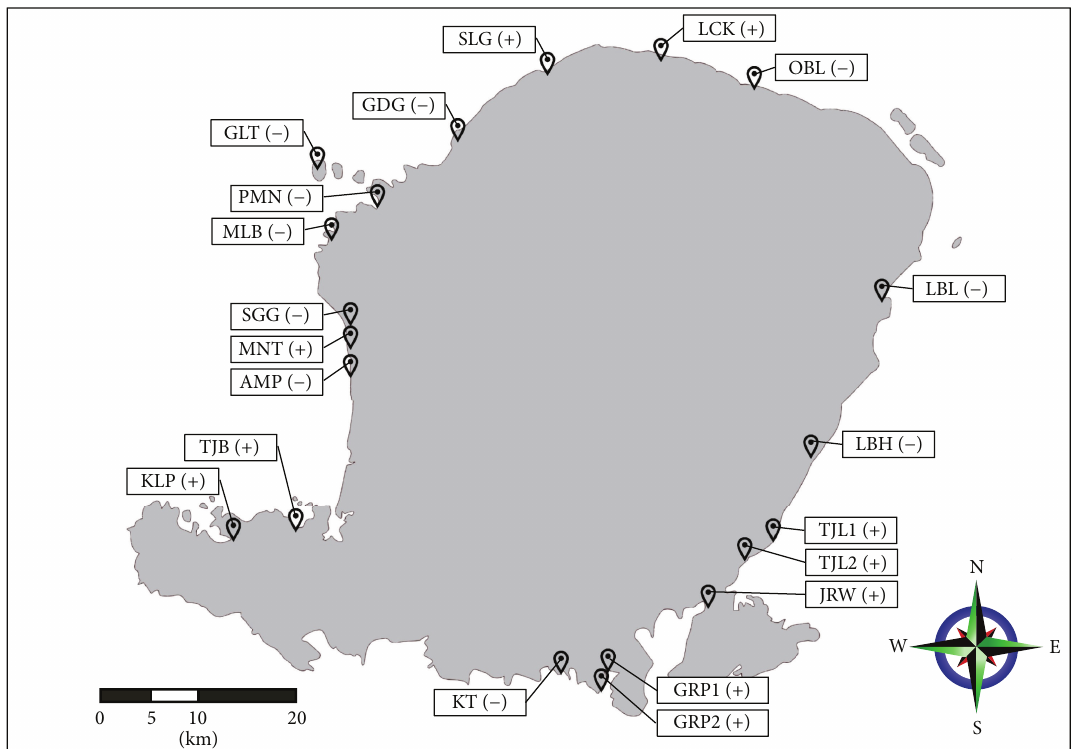
Figure 1: Sampling location of B. sphaericus around Lombok Island (Indonesia) and their toxicity attributes (( − ): nontoxic; (+): toxic).